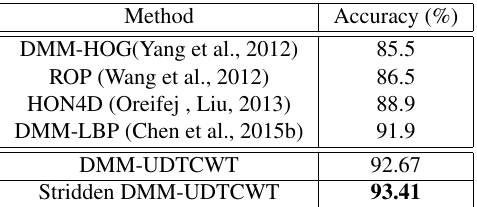
Table 2. Recognition accuracies under setting 2 on MSR Action 3D dataset .